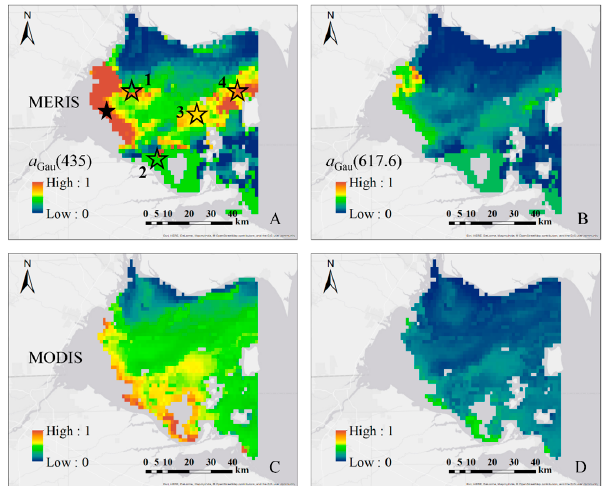
Figure 11. The spatial distributions of a Gau (435) and a Gau (617.6) in western basin of Lake Erie estimated from: MERIS (3 September 2011, 15:43:50 UTC) ( A , B ); and MODIS (3 September 2011, 18:55:00 UTC) ( C , D ) remote sensing reflectance imagery. The stars on ( A ) shows the locations of the mismatch between MERIS and MODIS imagery.